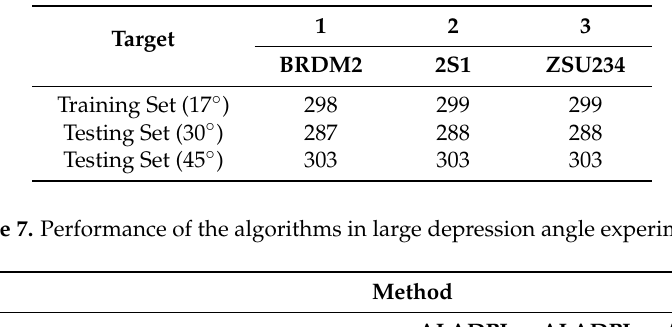
Figure 23. Performance of ALADPL with various aspect sector intervals. Table 6. Dataset used in large depression angle experiment.